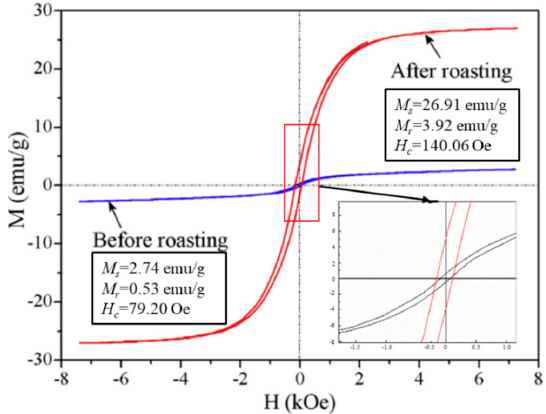
Figure 5. Magnetic hysteresis loops of the raw sample and magnetic fraction from the roasted sample. The roasted sample was treated with 5 kW of microwave power in Exps. C.